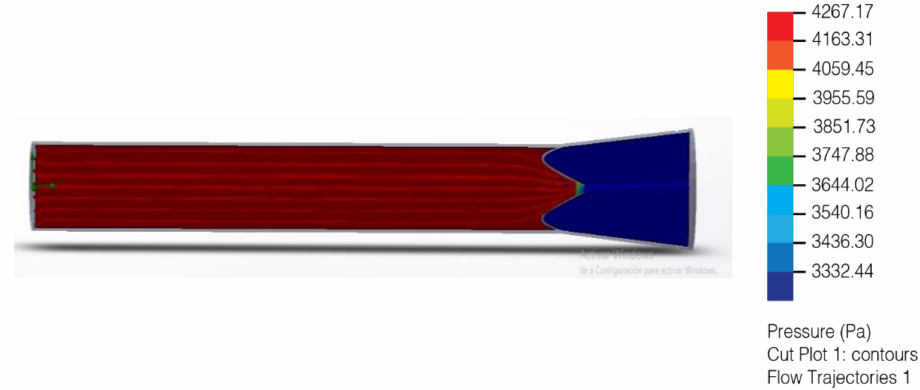
Figure 12. Flow of the liquid in relation to the pressure in the inlet and the outlet valves (2020).